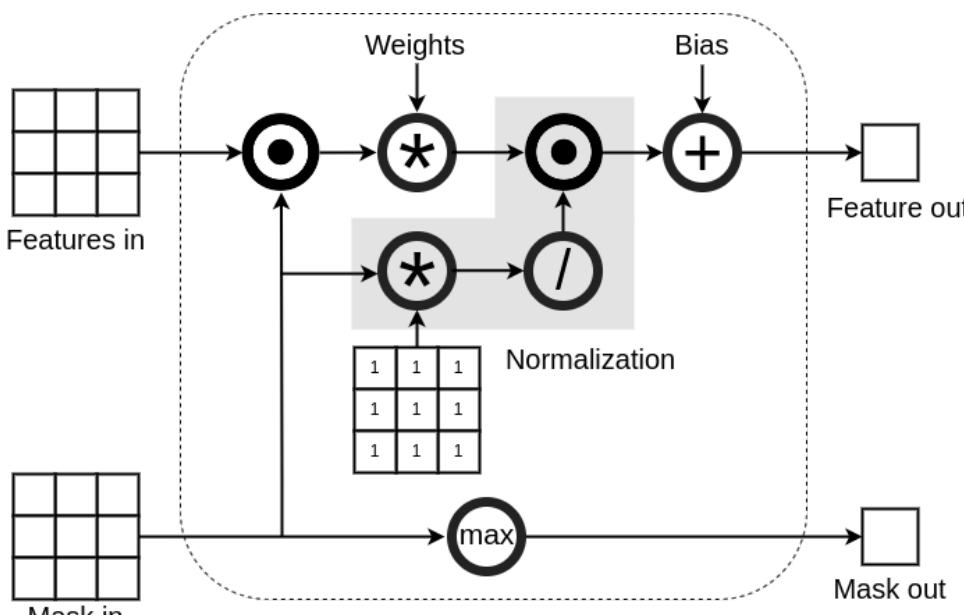
Figure 3. Sparsity Invariant Convolution operation diagram. Layer dedicated to handle convolution with significantly sparse input data. It uses mask, propagated along the features, to keep track of empty inputs deep within the network structure, which are then mask before multiplication with layer trainable weights. Additionally, results are scaled accordingly to mask values before adding a